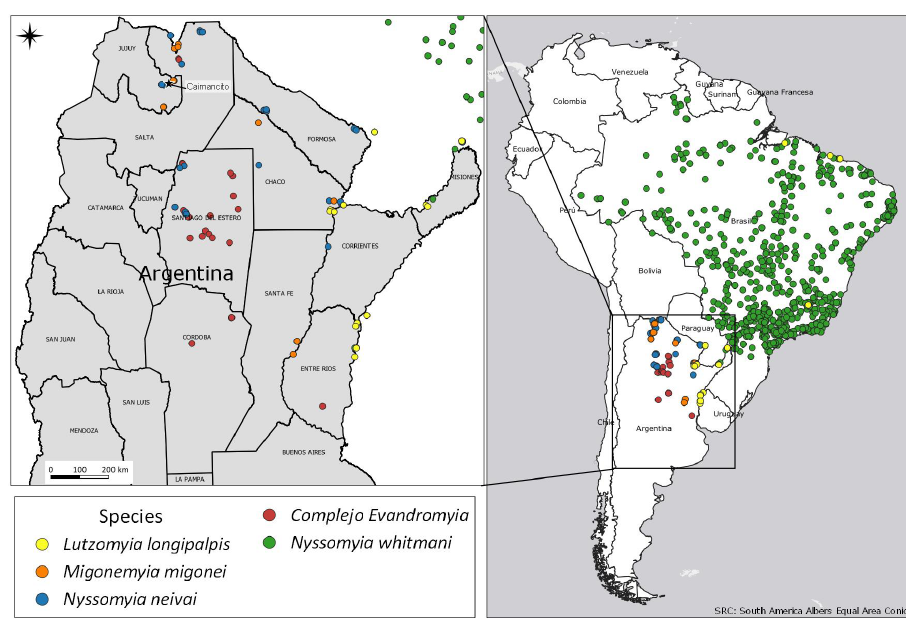
Figure 1. Occurrence location of the five sandflies species for South America (right) and for the study area (left). The location of Caimancito is shown in Jujuy province,